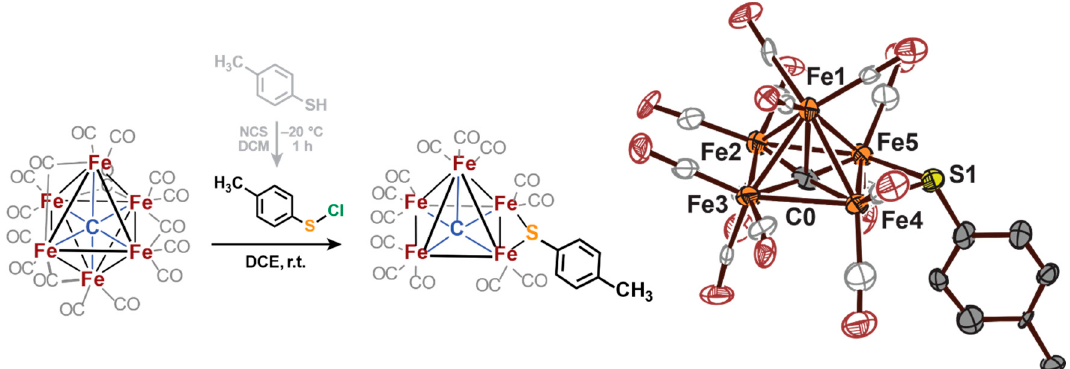
Figure 13. Reaction conditions (left) to obtain (NEt 4 )[Fe 5 ( µ 5 -C)(SC 7 H 7 )(CO) 13 ] and thermal ellipsoid plots (50% probability) of the thiolate-bearing cluster anion (right). Image adapted with permission from Joseph, C., Cobb, C. R., Rose, M. J. Single-Step Insertion of Sulfides and Thiolate into Iron Carbide-Carbonyl Clusters: Unlocking the Synthetic Door to FeMoco Analogues. Angew. Chemie Int. Ed. 2020 , Accepted, not yet published . Copyright Wiley-VCH GmbH . Reproduced with permission.